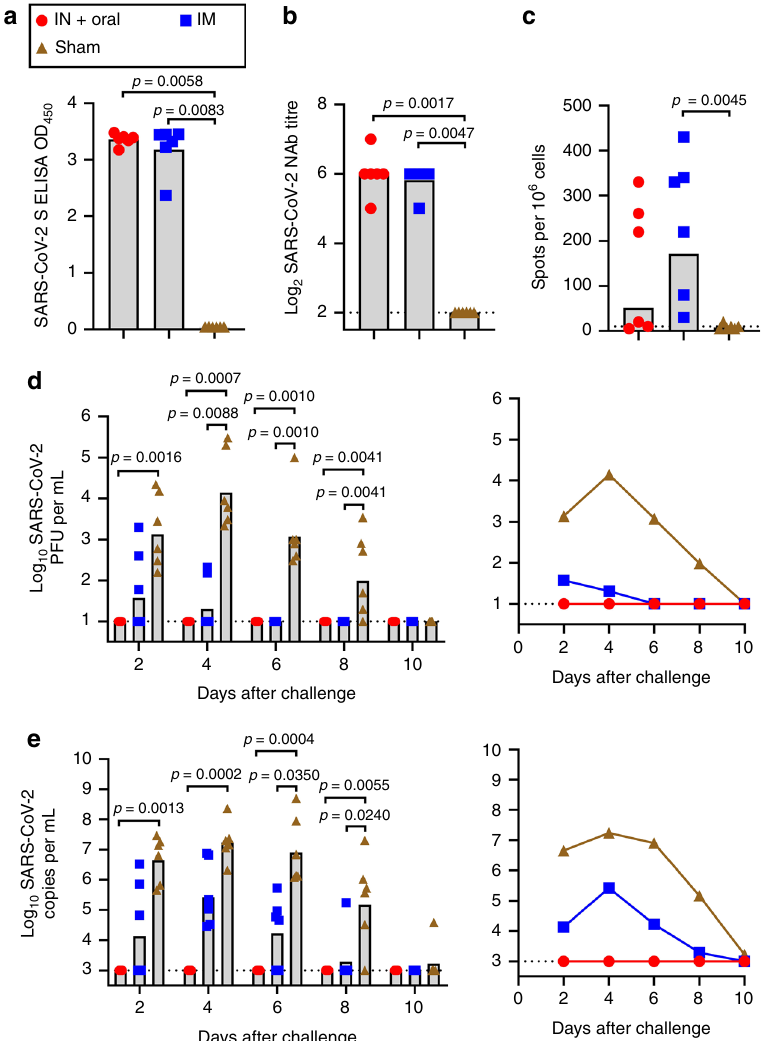
Fig. 3 Immunogenicity and protective ef fi cacy of Ad5-nCoV in ferrets. Ferrets ( n = 6 biologically independent animals per group) received a single immunization by the IM route or two simultaneous doses by the IN and oral routes with 5 × 10 10 VP per dose of Ad5-nCoV or received a sham vaccine. Humoral immune responses were assessed at week 4 following vaccination by S-speci fi c ELISA ( a ) and NAb titration (PRNT 90 ) ( b ). c Cellular immune response was assessed by IFN γ ELISpot assays. Live virus numbers ( d ) and viral load ( e ) of SARS-CoV-2 in nasal washes obtained from ferrets after challenge. Bar at the geometric mean, and connecting lines re fl ect geometric means; statistical signi fi cance was determined by Kruskal – Wallis ANOVA with Dunn ’ s multiple comparisons tests; IN and oral inoculation animals = red circles; IM injection animals = blue squares; control animals = brown triangles; dotted line = the limit of detection. Source data are provided as a Source Data fi